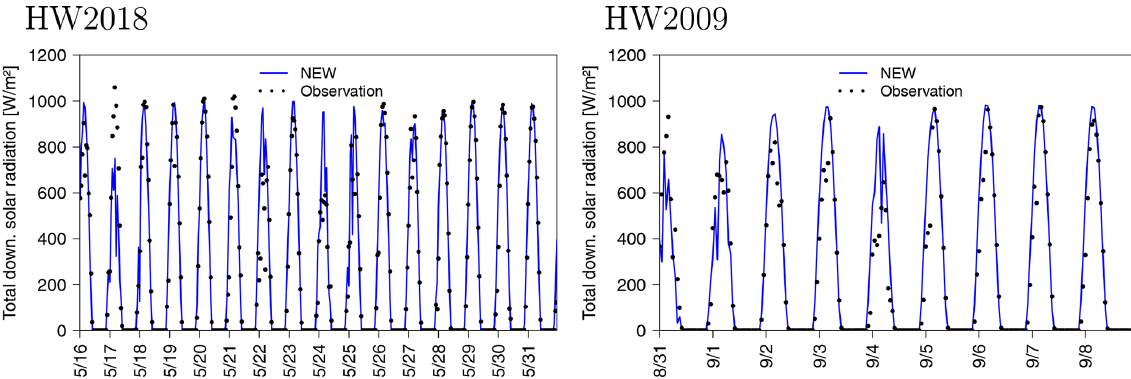
Figure 4. Time series (UTC) of simulated (NEW coupling approach, D4) and observed solar radiation at the KP station.